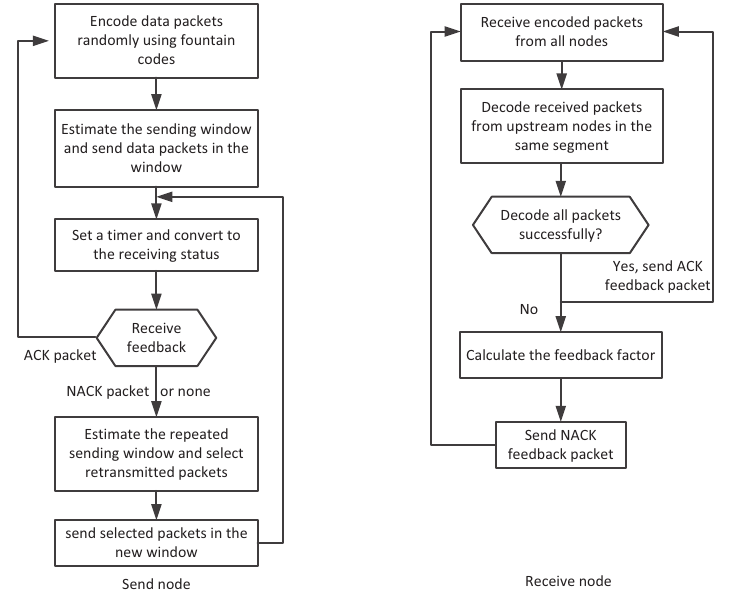
Figure 3. The overall process of network coding based hybrid ARQ (NCHARQ)